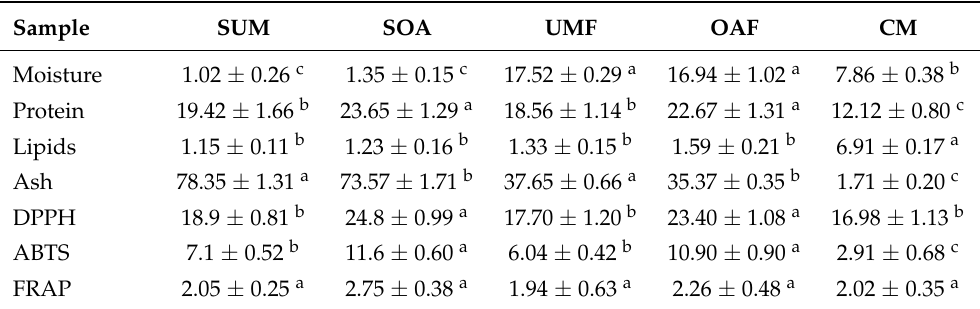
Table 1. Chemical composition (%) and antioxidant activity measured in terms of DPPH (%), ABTS- radical scavenging activity ( µ M TE/g dm) and FRAP activities ( µ M TE/g dm) of dry-salted jellyfish umbrella (SUM), oral arms (SOA) and umbrella (UMF), oral arm (OAF) flour and cornmeal (CM) 1 . Sample